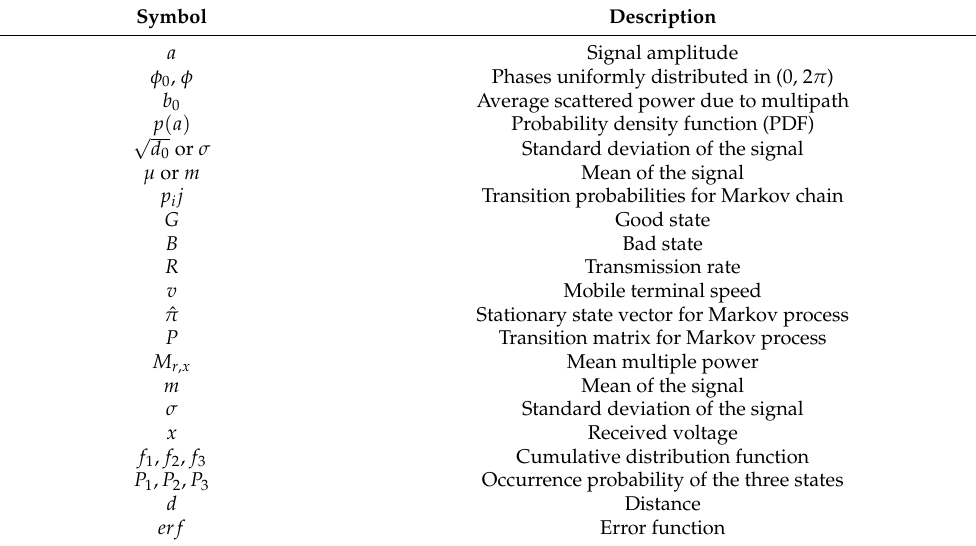
Table 4. Symbols used in the LMS channel model section.